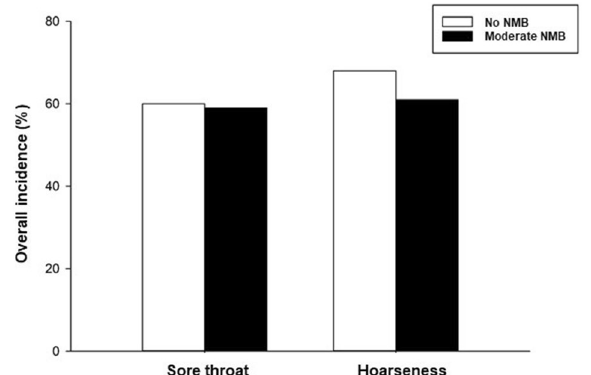
Figure 3. Overall incidence of postoperative hoarseness sore throat and hoarseness. NMB neuromuscular